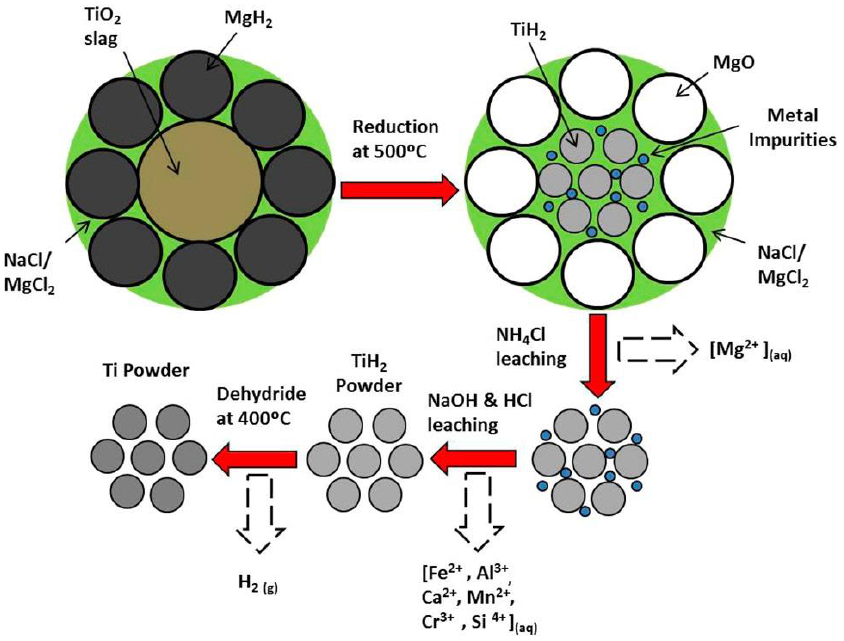
Figure 7. Schematic illustration of producing titanium from TiO 2 -based titanium slag using MgH 2 [69] (Adapted from [69], with permission from ACS Publications, 2013).